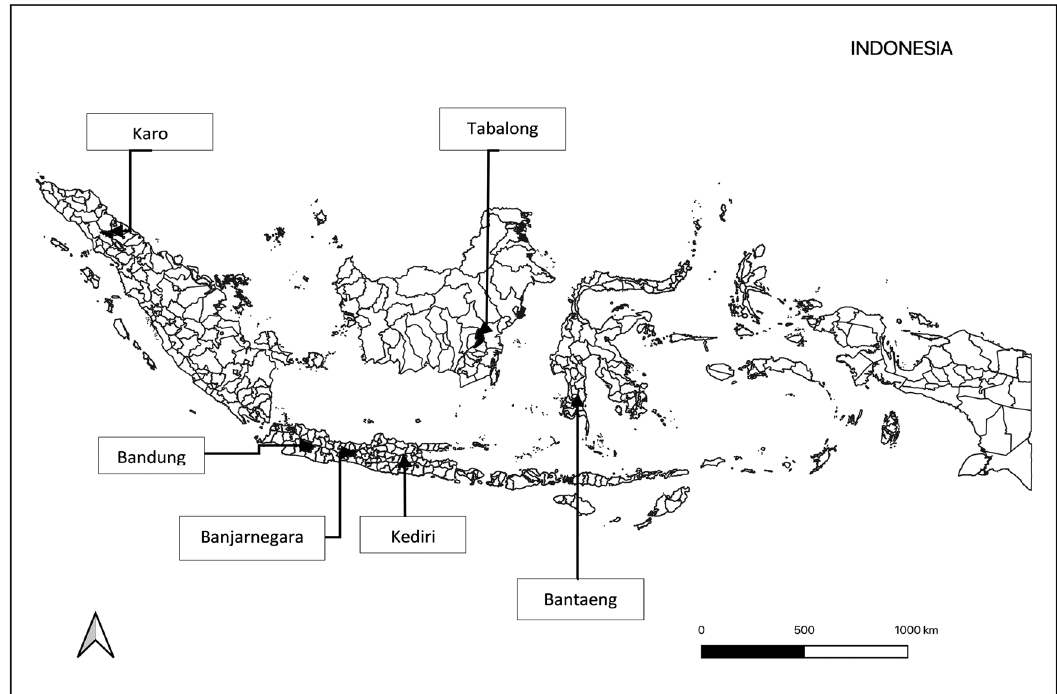
Figure 1: Location of the